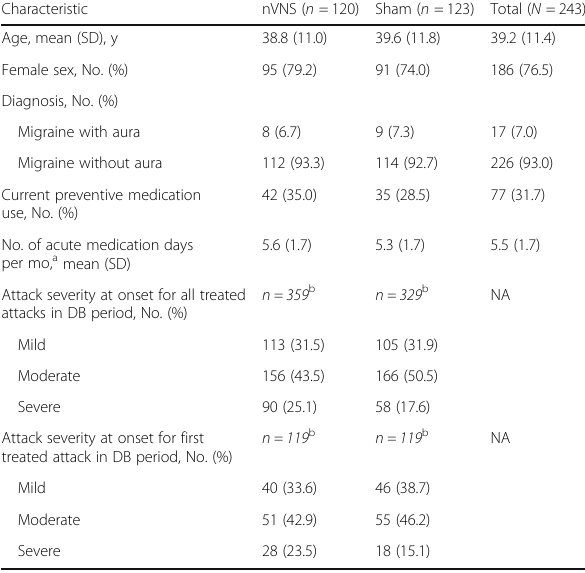
Table 1 Demographics and other key patient characteristics Characteristic